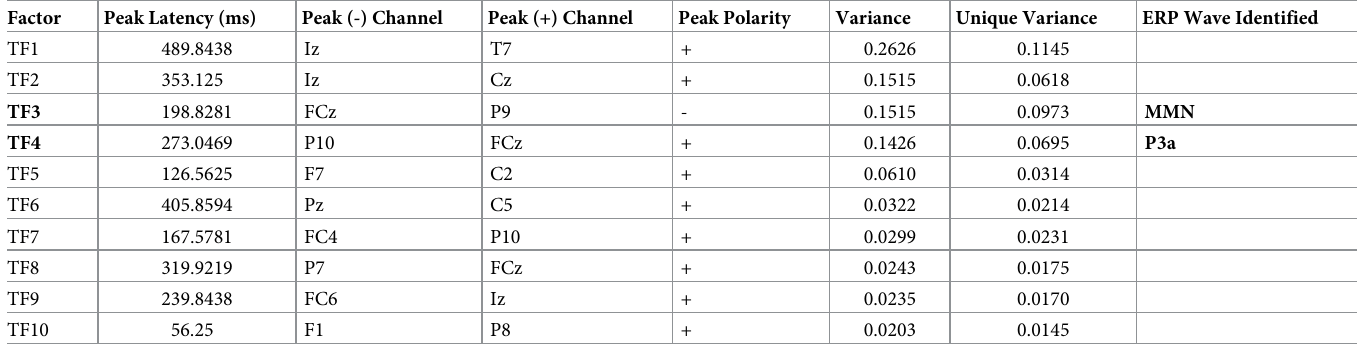
Table 1. Temporal PCA factors: All the factors identified are ordered by the explained variance, with their latency (ms), maximum negative and positive locations and peak polarity. The factors with the event-related potential (ERP) components of interest for the study (MMN and P3a) are included in the final column. Factor Peak Latency